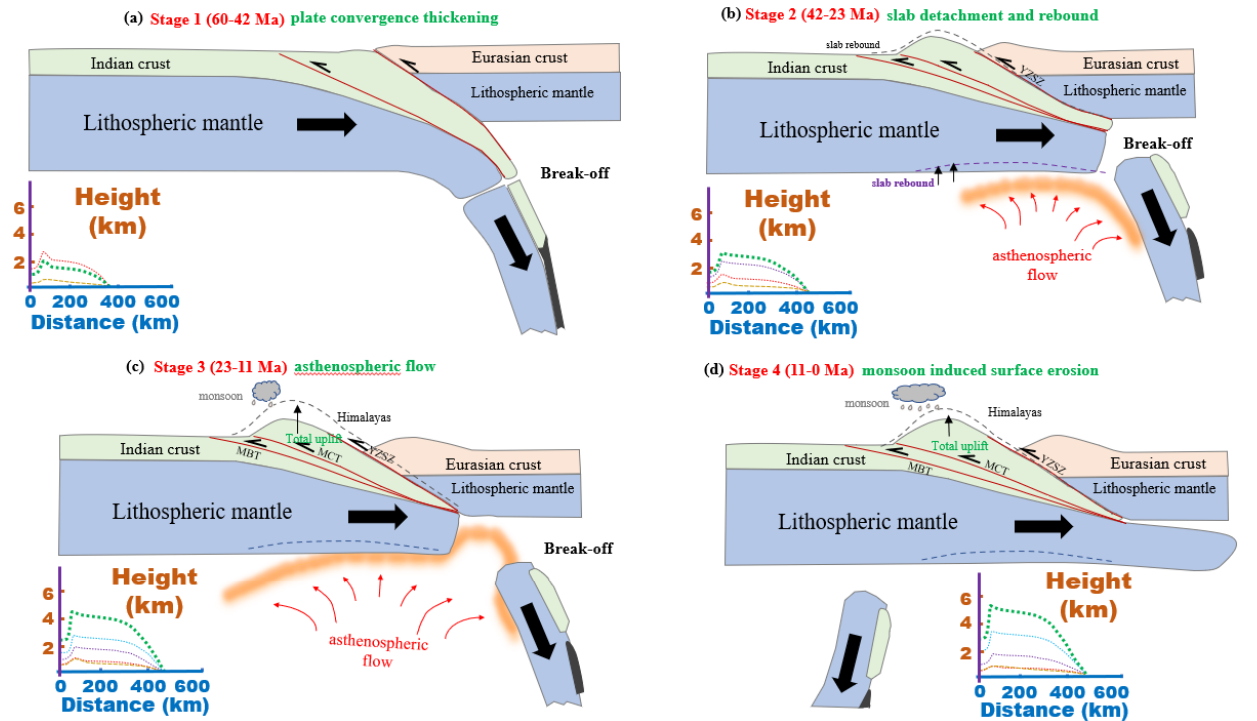
Figure 5. Schematic illustration of the 2-D tectonic evolution of the Himalayan orogeny corresponding to the four evolutionary stages of the Himalayas. The insets indicating variation of the height along the distance are specified in Figure 6. ( a ) Plate-convergence-induced thickening (60−42 Ma). ( b ) Progressive uplift of the Himalayas caused by slab detachment and rebound (42−23 Ma). ( c ) Upward asthenospheric flow causes rapid uplift of the Himalayas (23−11 Ma). ( d ) Slowed uplift of the Himalayas affected by s urface erosion (11−0 Ma).